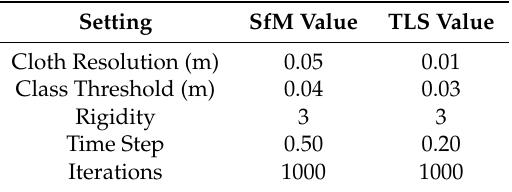
Table 1. Filter settings applied to the Cloth Simulation Filter for SfM and TLS point clouds to identify ground points in all sites. The same parameters were used for generating point clouds for each technology source. Setting SfM Value TLS Value Cloth Resolution